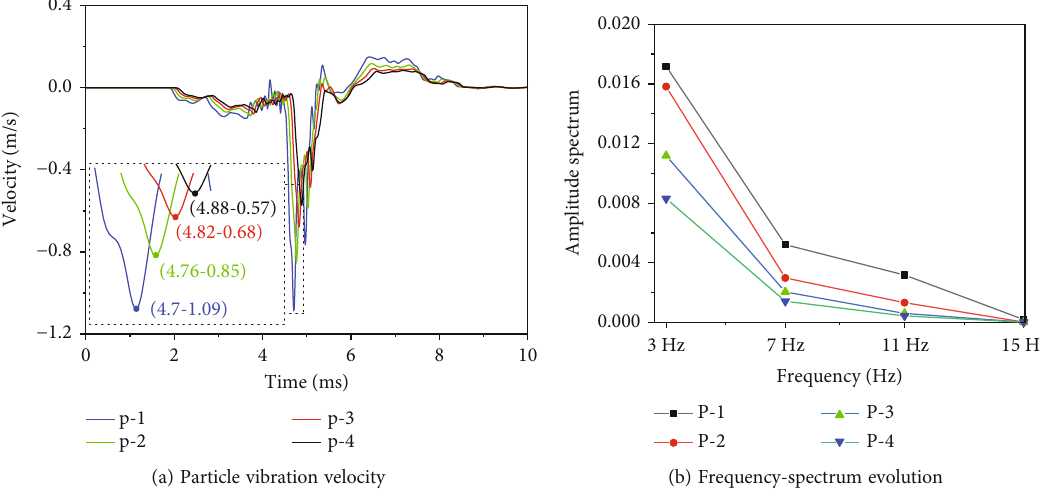
Figure 12: (a) Vibration velocity and (b) frequency-spectrum evolution under the action of blasting stress